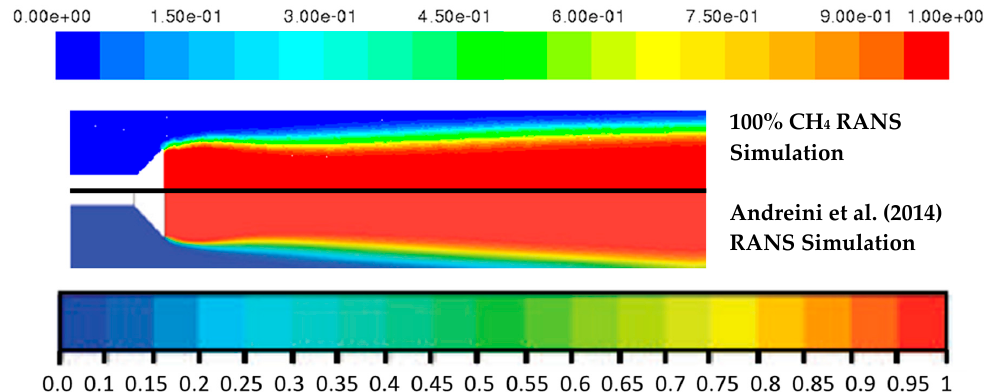
Figure 8. Comparison of the progress variable θ for a burner fueled with the methane–air mixture with respect to the RANS simulation of the burner developed by Andreini et al.